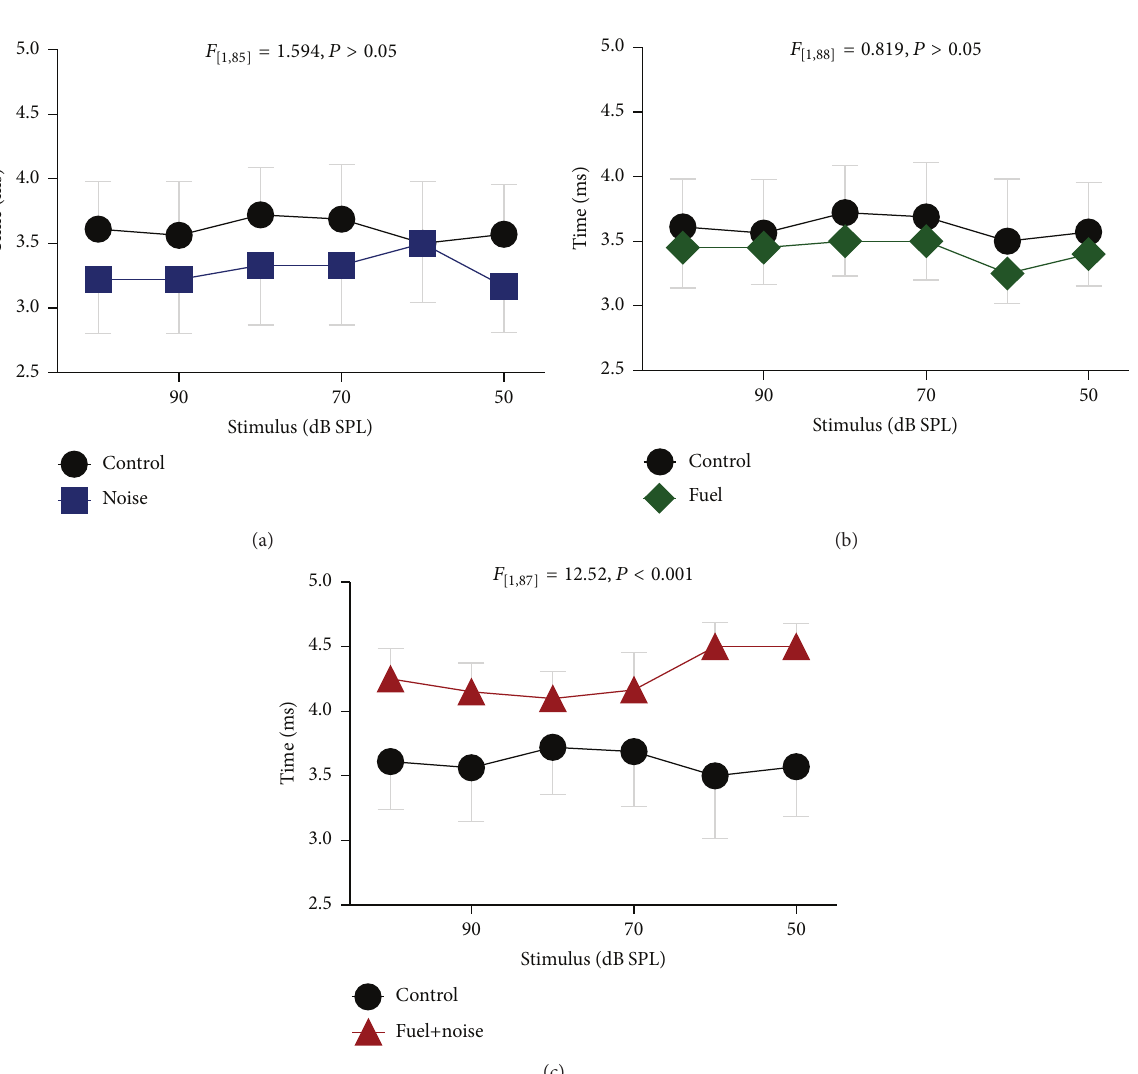
Figure 3: Abnormal conduction time. The time difference between P 2 and N 0 was measured for each exposure group and compared to that of the nonexposed (control) group. Both the (a) noise and (b) fuel exposed groups exhibited conduction times that were generally similar to that of the control group. However, the fuel+noise group exhibited major delays in conduction time (c). of the brain. The main findings indicate that the